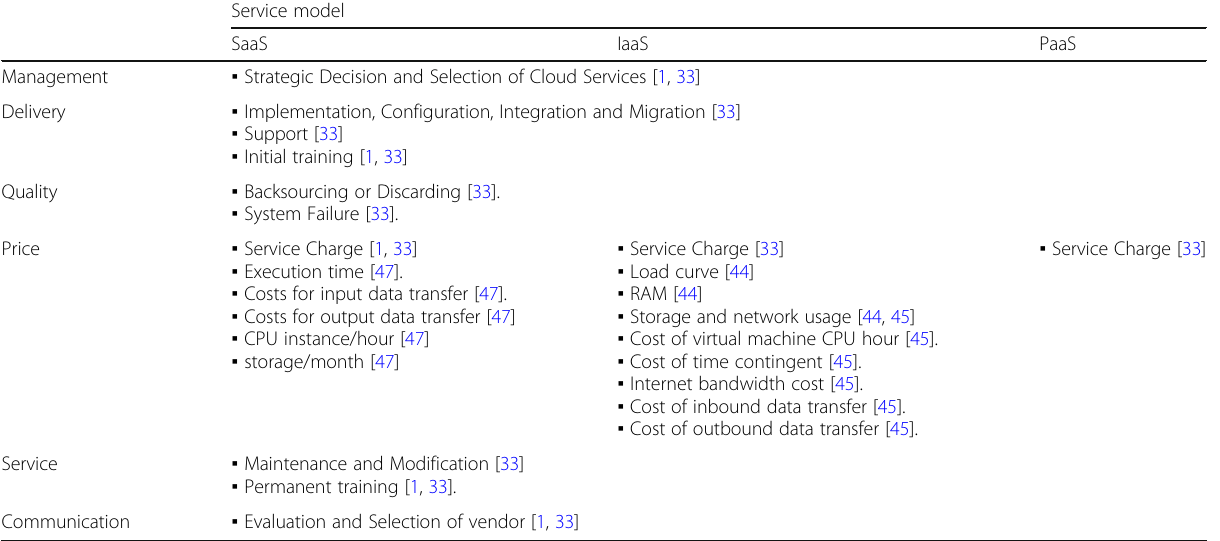
Table 1 Cost areas of cloud computing TCO Service